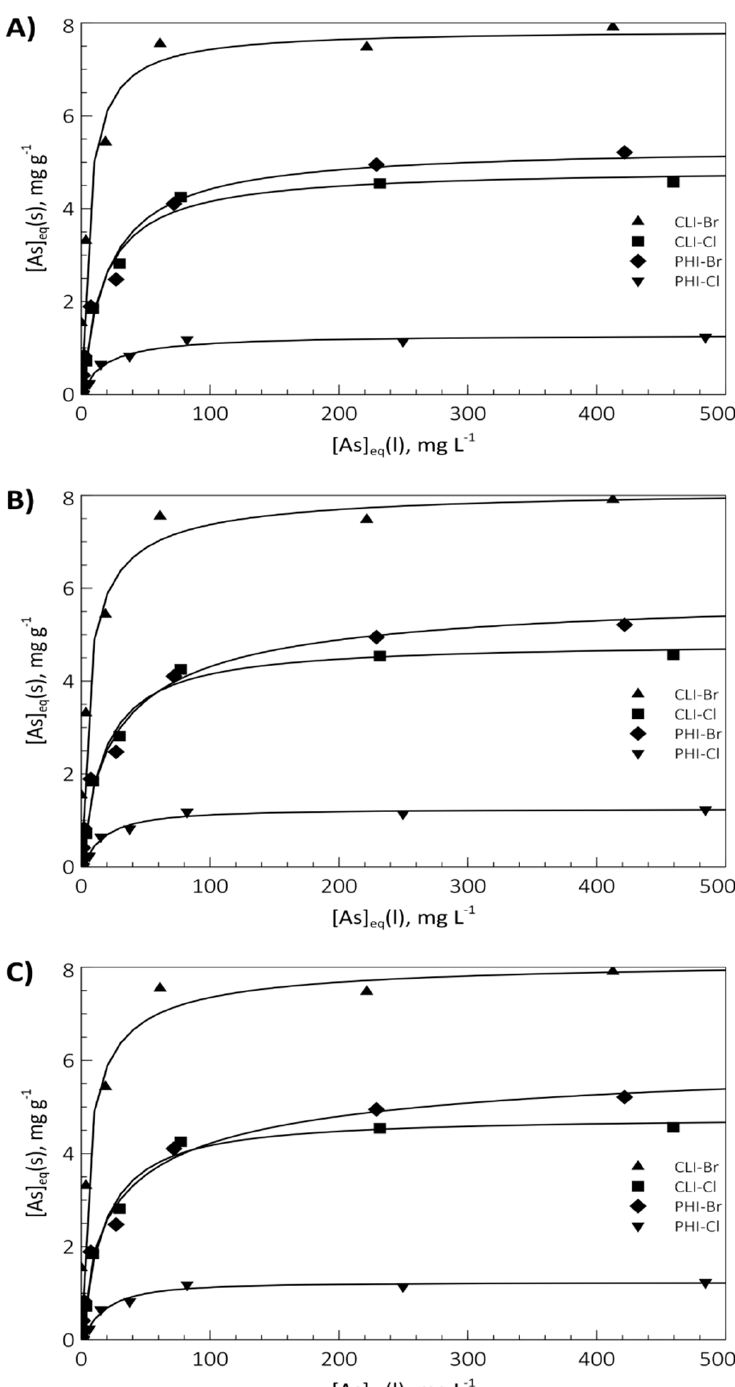
Figure 7. As adsorption isotherms and best fitting Langmuir ( A ), Sips ( B ) and Toth ( C ) curves.